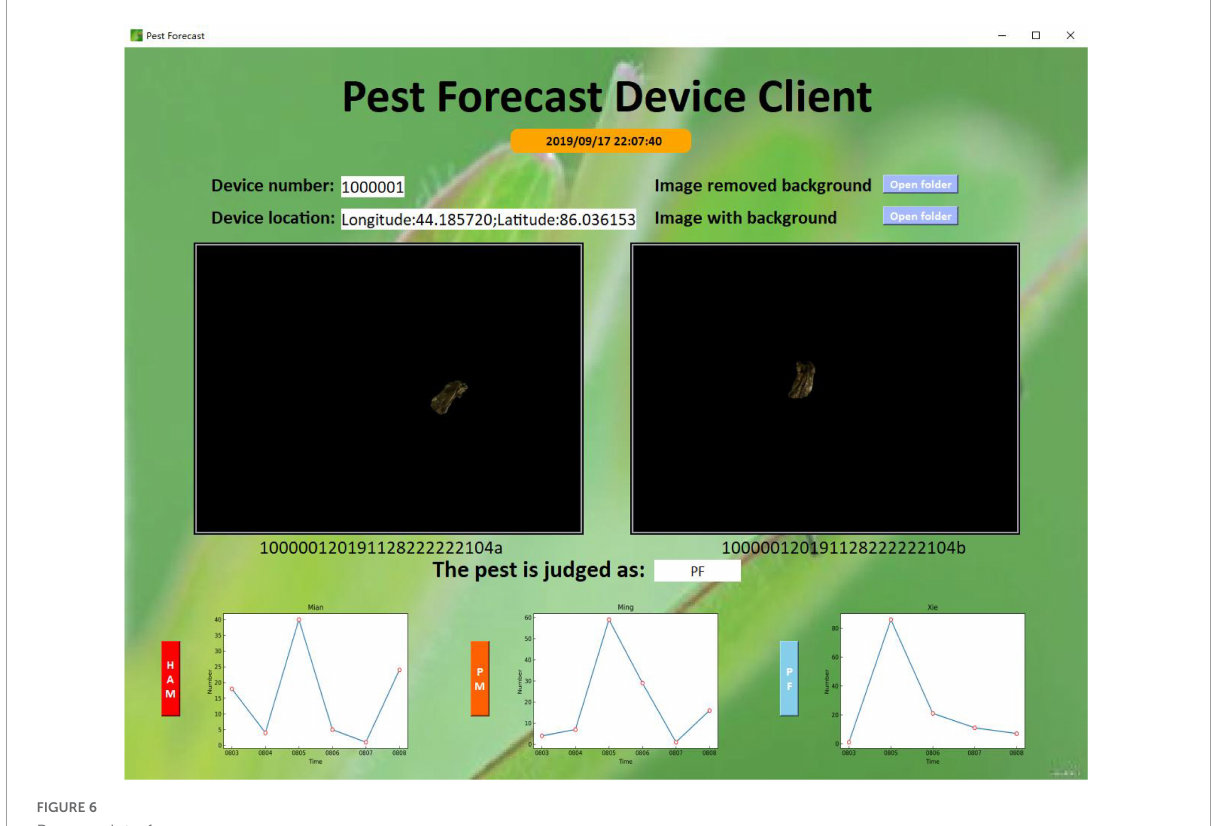
FIGURE6 Program